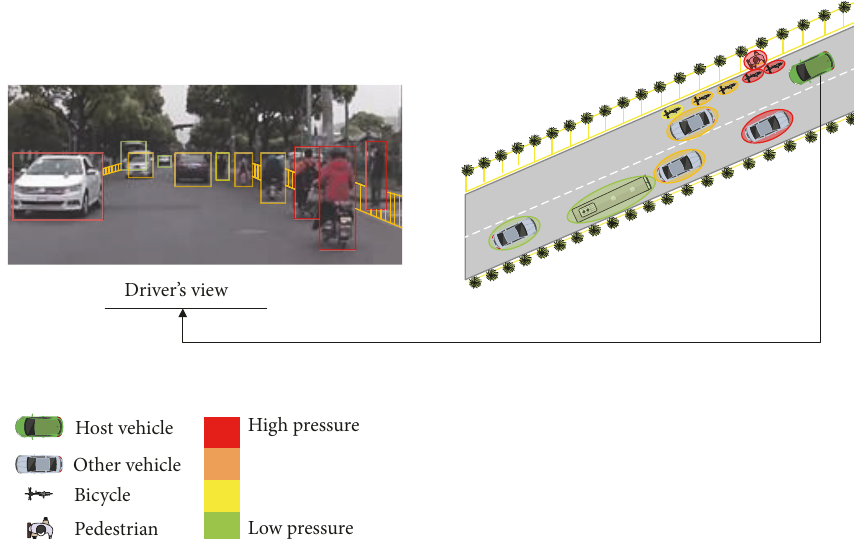
Figure 1: Conceptual image of pressure field from driver’s